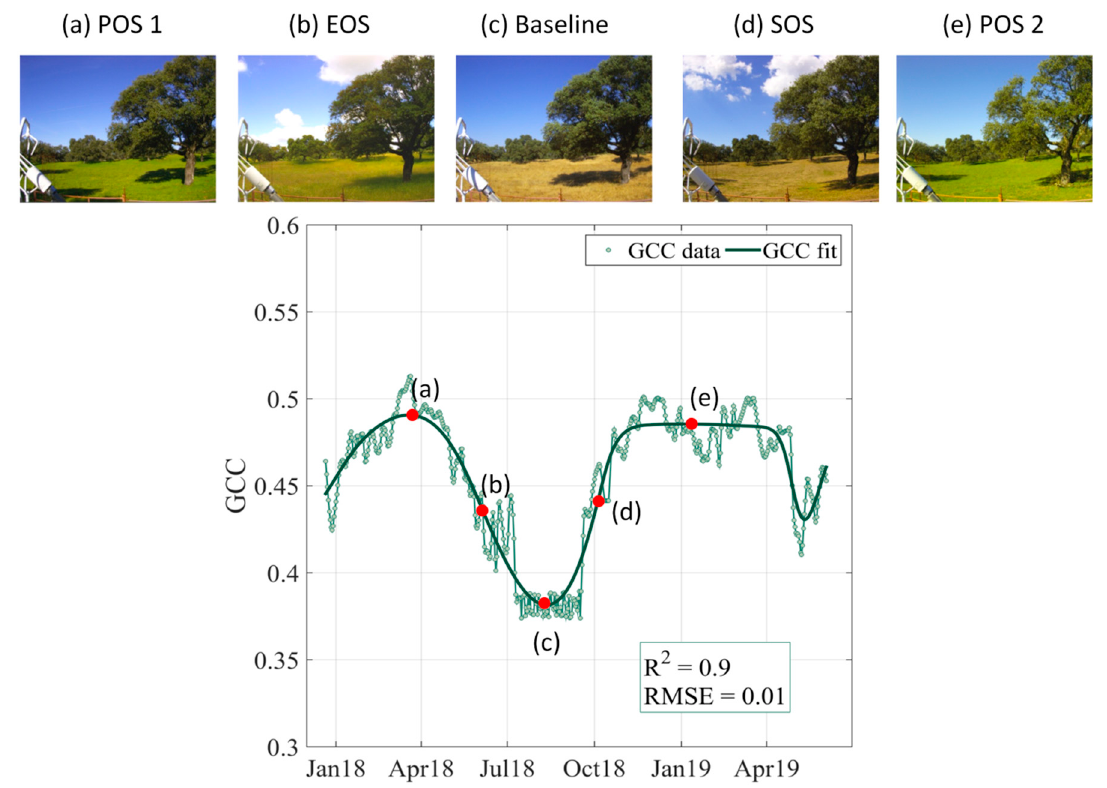
Figure 3. Evolution of GCCc (raw data, fitted function and error) throughout period A and corresponding images of the phenological dates (red dots): ( a ) peak of season (POS) 1 (03/22); ( b ) end of season (EOS (06/05); ( c ) Baseline (08/17); ( d ) start of season (SOS) (10/17); ( e ) POS 2 (01/15).